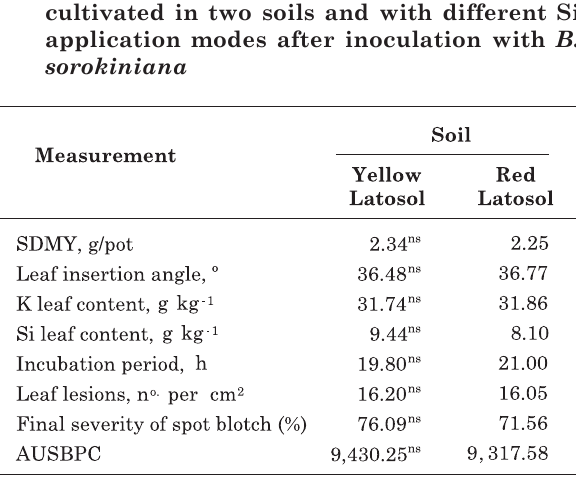
Table 2. Shoot dry matter yield (SDMY), leaf insertion angle, K and Si leaf content, incubation period, lesions per cm² of leaf area, final spot blotch severity and area under the spot blotch disease progress curve (AUSBPC) in wheat cultivated in two soils and with different Si application modes after inoculation with